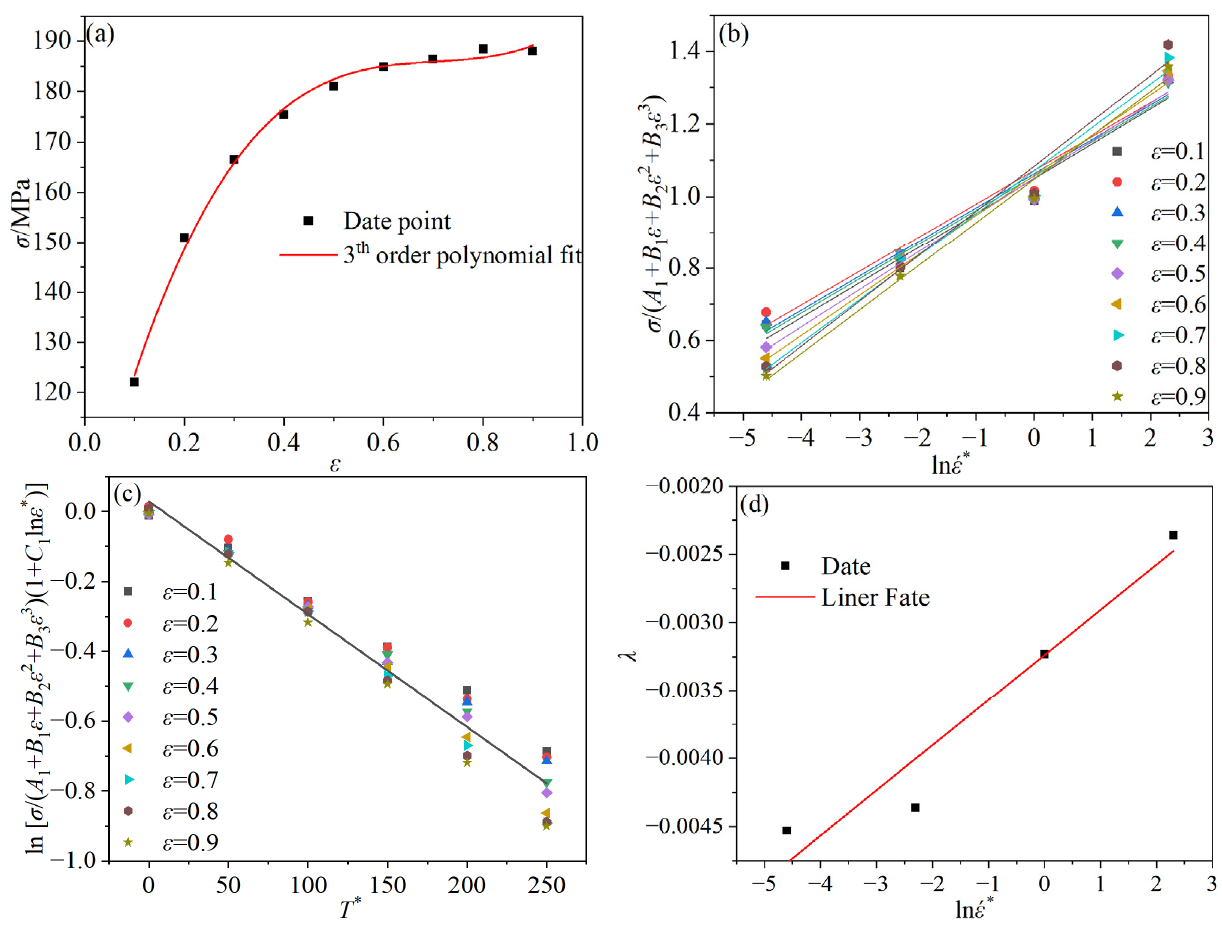
Figure 5. Relationship between: ( a ) σ and ε at 1123 K and 1 s - 1 ; ( b ) σ / (cid:3435) A the temperature of 1123 K; ( c ) ln (cid:3428)